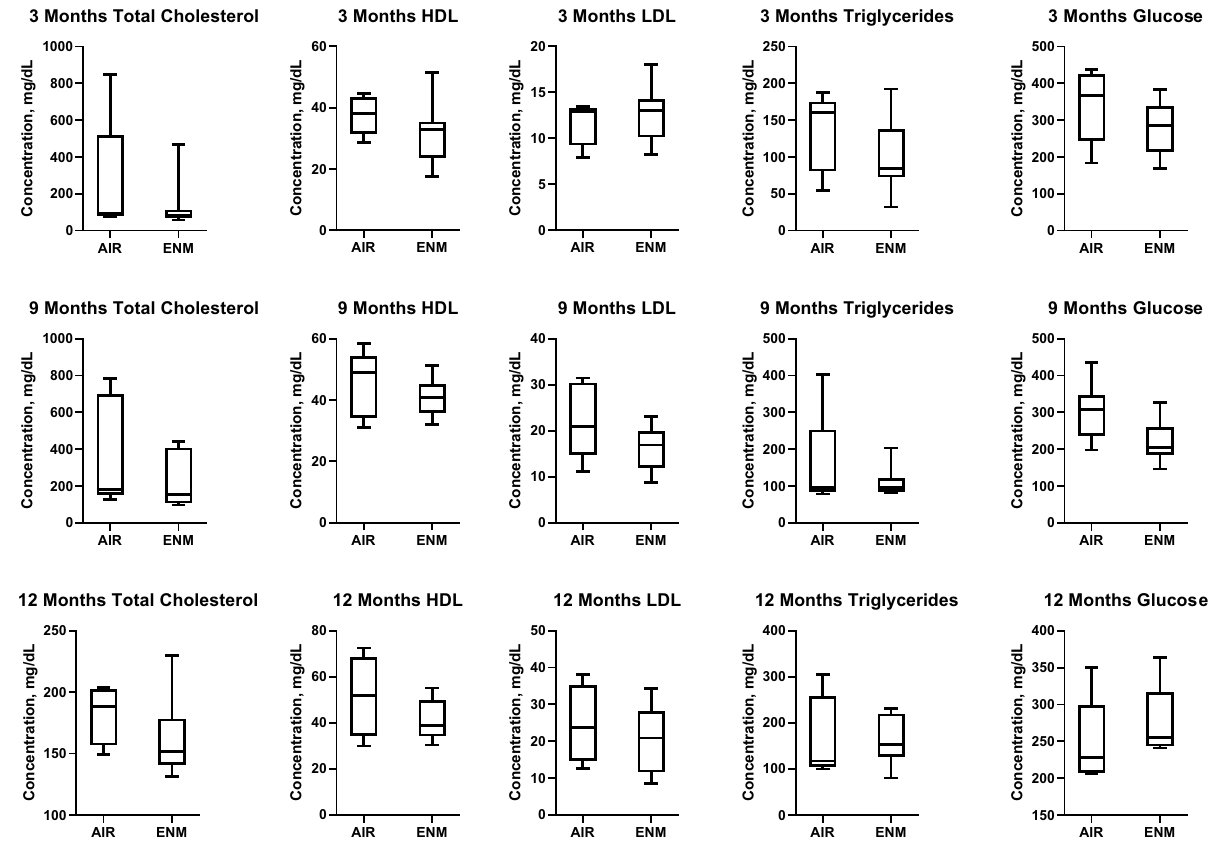
Figure 6. Metabolic panel. Plasma cholesterol, HDL, LDL, and triglycerides were assessed in offspring between Sham-Control or ENM groups at 3, 9, and 12 months of age. HDL, High density lipoprotein; LDL, low density lipoprotein. Values are shown as mean ±